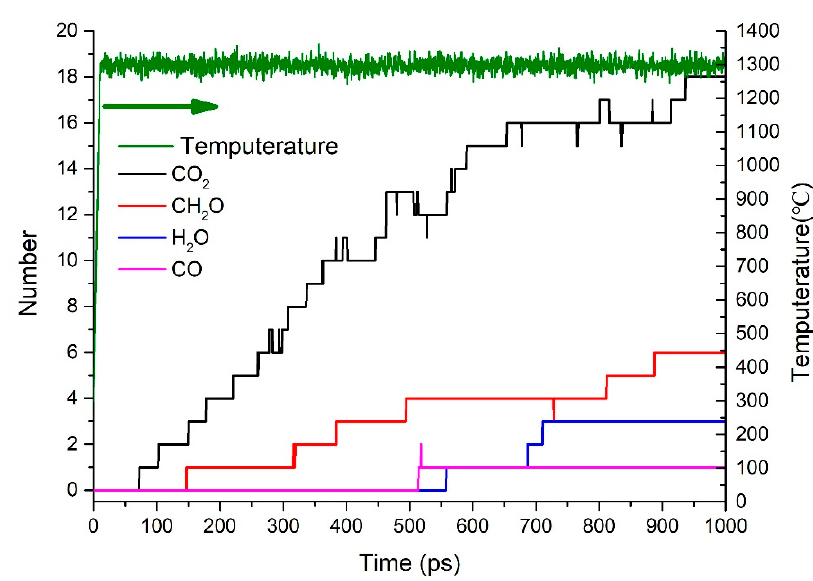
Figure 6. Time evolution of CO 2 , CH 2 O, H 2 O, CO, and temperature.